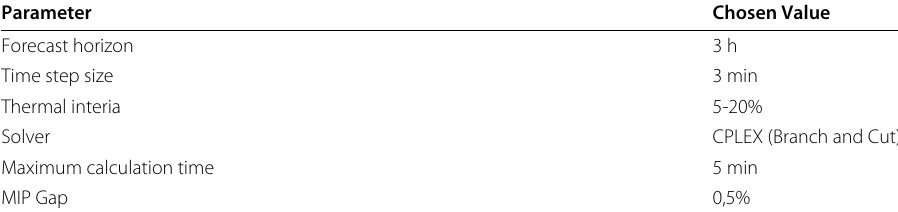
Table 2 Calculation settings of the MILP-based control algorithm Parameter Chosen Value Forecast horizon 3 h Time step size 3 min Thermal interia 5-20% Solver CPLEX (Branch and Cut) Maximum calculation time 5 min MIP Gap